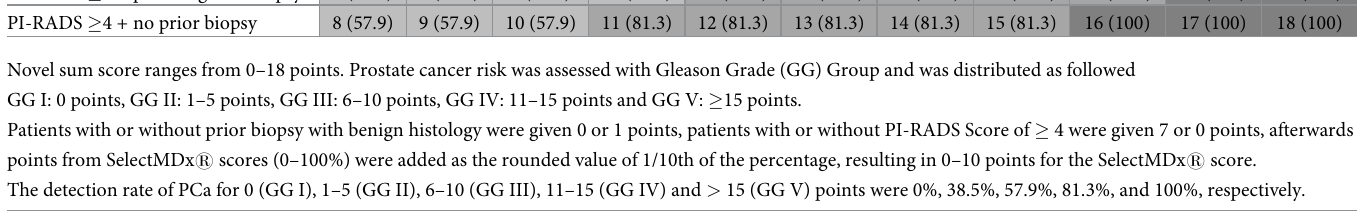
Table 2. Novel sum score derived from the combination of PI-RADS, history of prior biopsy and SelectMDx 1 score. PI-RADS / / history of biopsy / SelectMDx Score (%) PI-RADS � 3 + prior negative